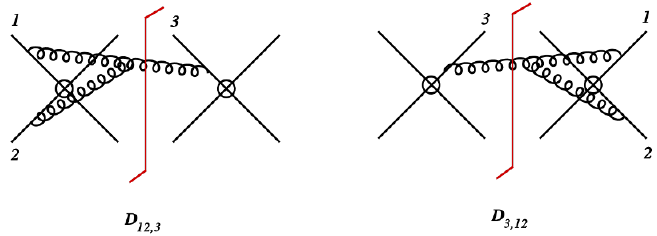
Figure 11 . Example of the three-Wilson-line, single-cut diagrams that yield non-vanishing, purely imaginary